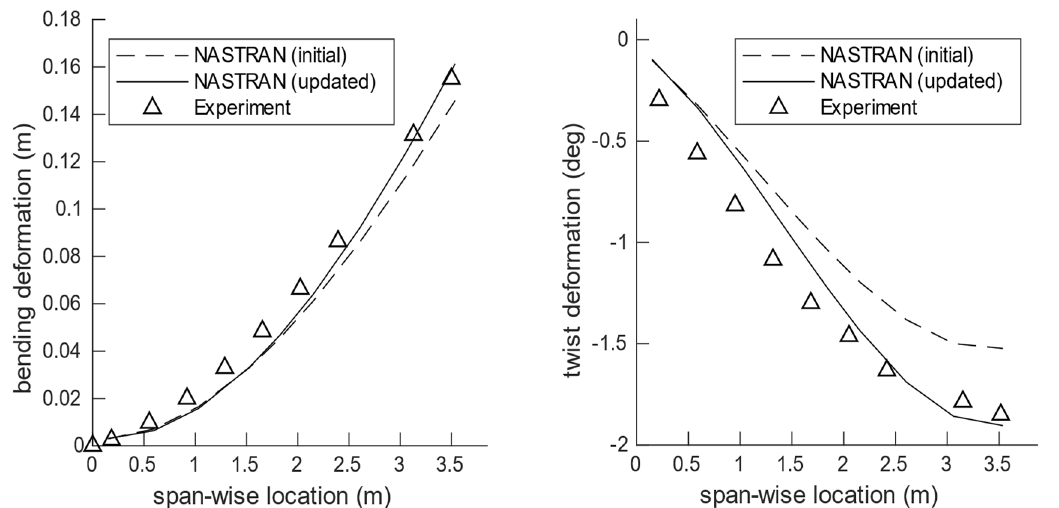
Figure 11. Displacement ( left ) and twist ( right ) comparing the initial FE model, updated FE model and static test experiments for the reference wing.